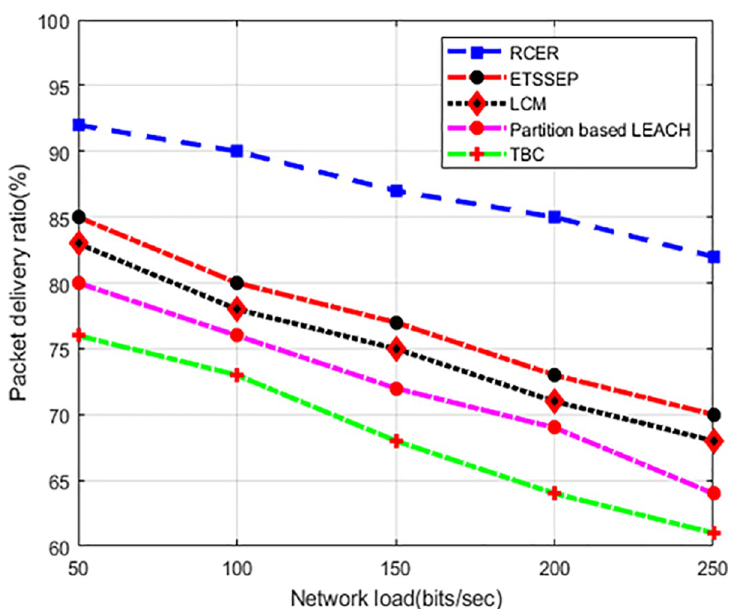
Fig 19. Packet delivery ratio in varying network